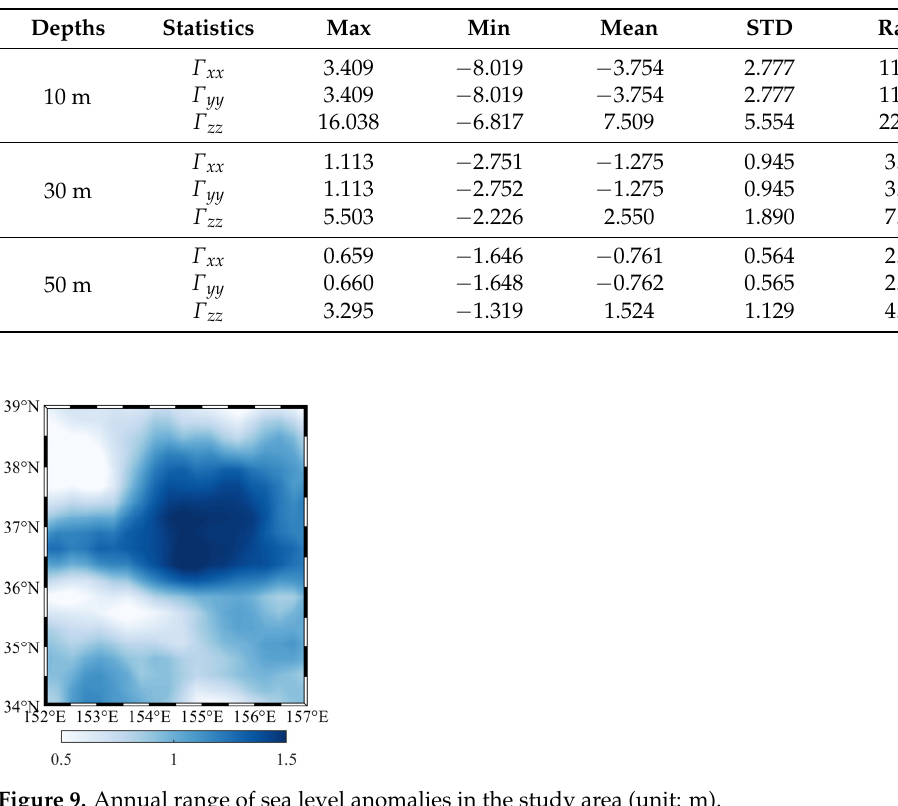
Figure 10. Annual range of the disturbing gravity gradient at 10 m below the mean sea level ( Γ xx and Γ yy are both negative, and the absolute values shown in ( a , b ). Γ zz is positive in ( c ). (unit: E).